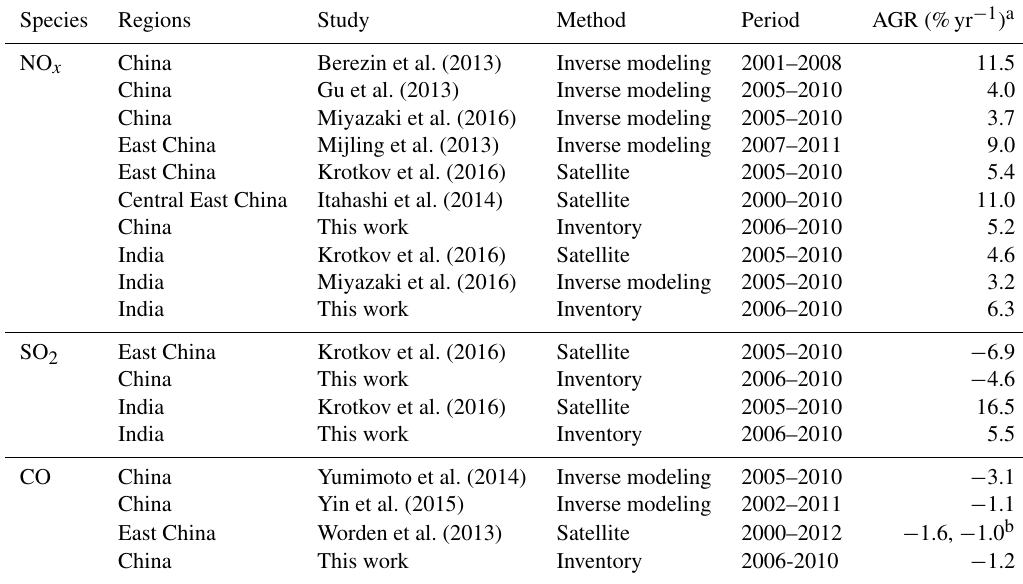
Table 6. Comparison of emission trends of NO x , SO 2 , and CO over Asia with satellite observations. Species